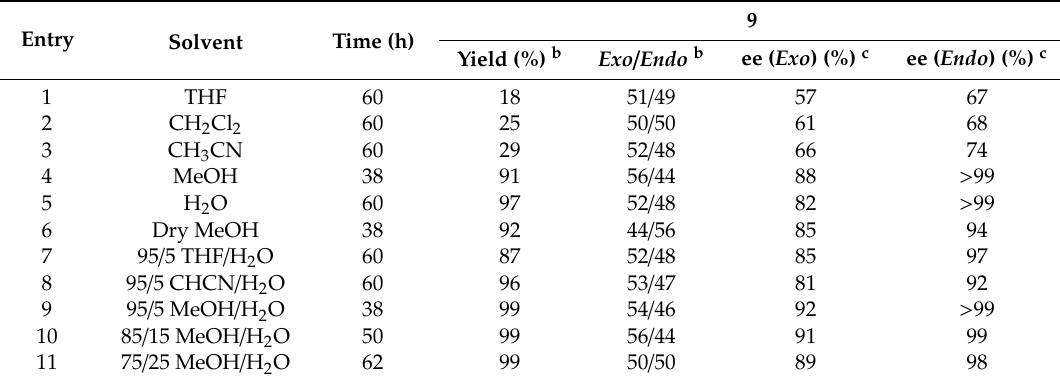
Table 3. Asymmetric DA reaction catalyzed by ICCC 6 a .